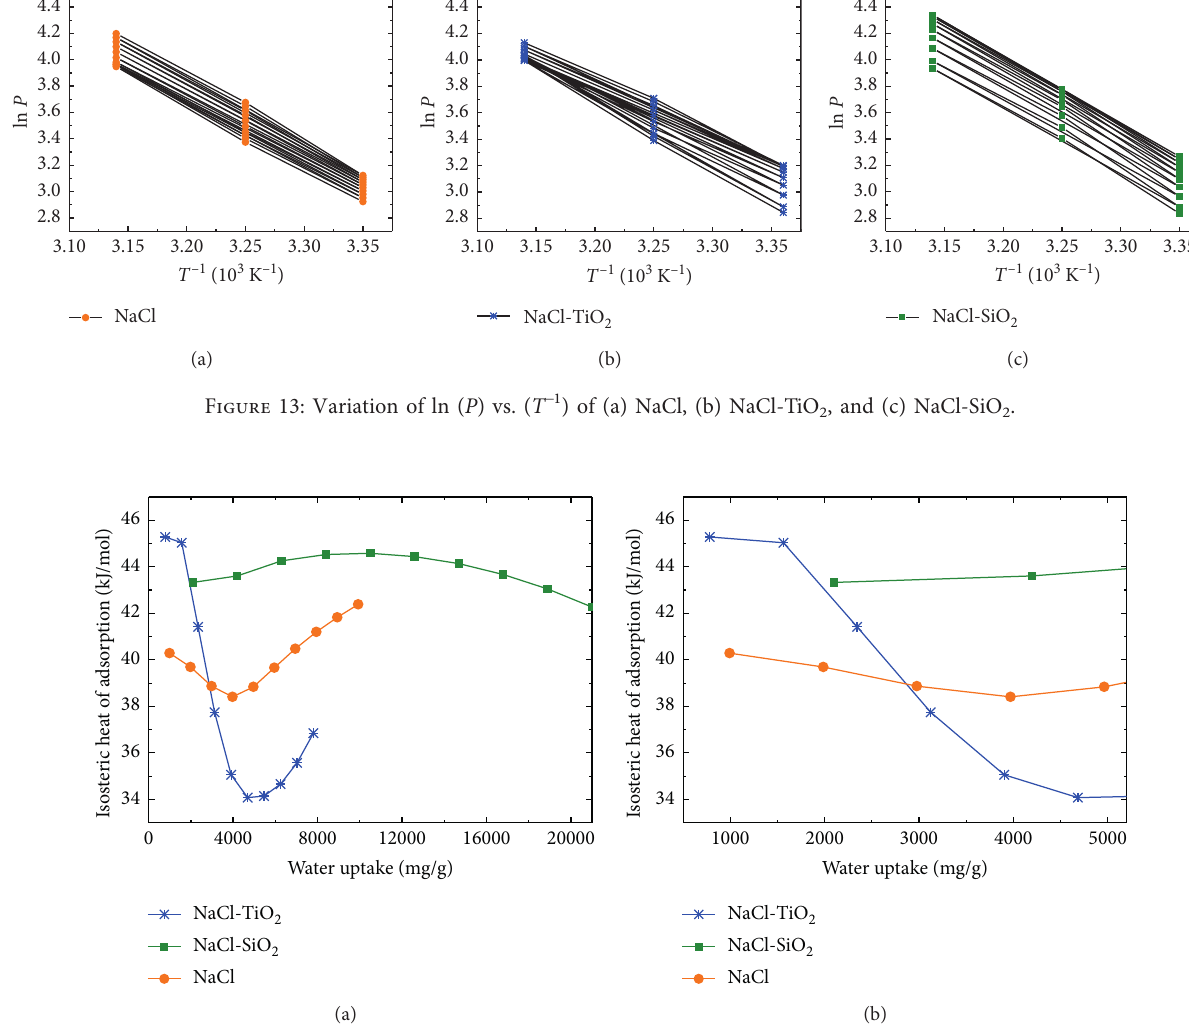
Figure 14: Isosteric heat of adsorption ( Δ H ads ) of NaCl, NaCl-TiO 2 , and NaCl-SiO 2 : (a) full scale; (b) the inset shows the range 500–5000mg · g − 1